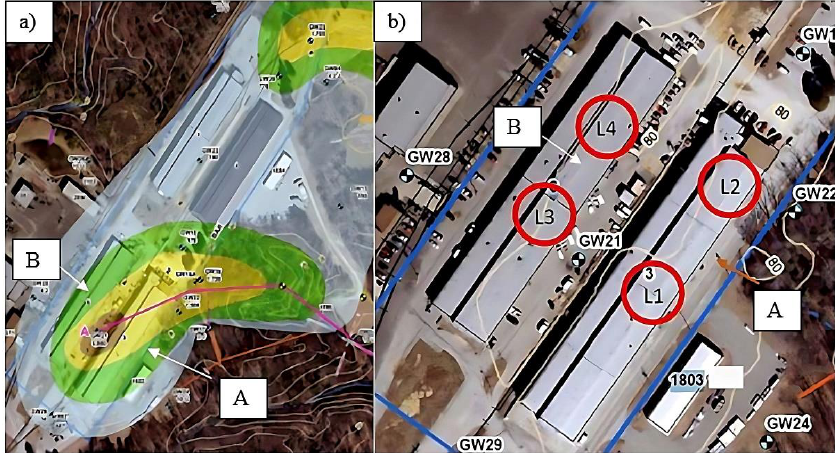
Figure 2. ( a ) Buildings (A and B) chosen for sampling depicting the contamination of groundwater beneath each building (brown = most contamination; yellow = medium contamination; green = low contamination; and gray = possible contamination). ( b ) An enlarged view of the buildings with ap- proximate sampling locations labeled L1 – L4 and circled in red. Note: GW labels represent some